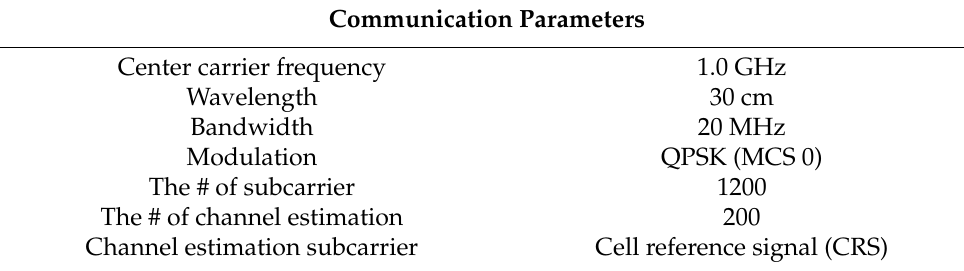
Table 3. Software defined communication